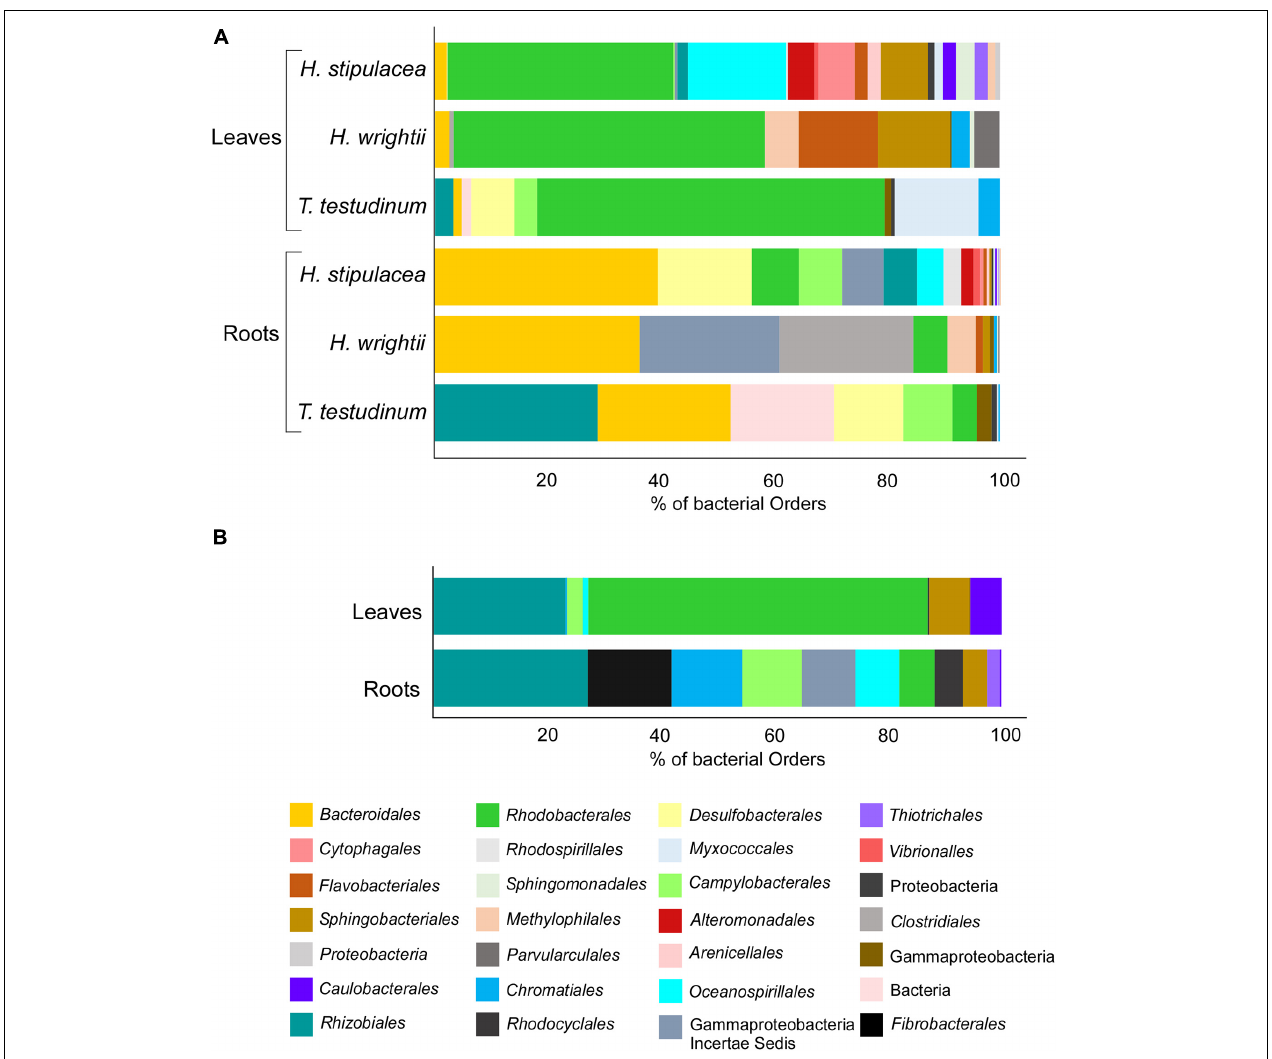
FIGURE 6 | Seagrass core species-specific bacterial structure based on the Venn diagram from Figure 5 with OTUs grouped by order level: (A) Roots and leaves of H. stipulacea , H. wrightii , and T. testudinum and (B) their shared core community (“core of the core”), associated with roots and leaves. Colors were changed so the same bacterial order would have matching colors in the different